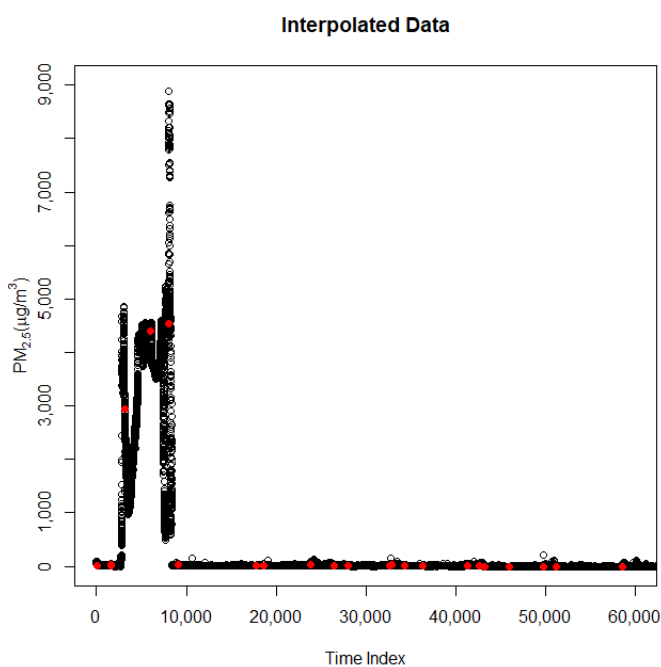
Figure 7. Optimal bandwidth for this dataset is chosen as being 19.